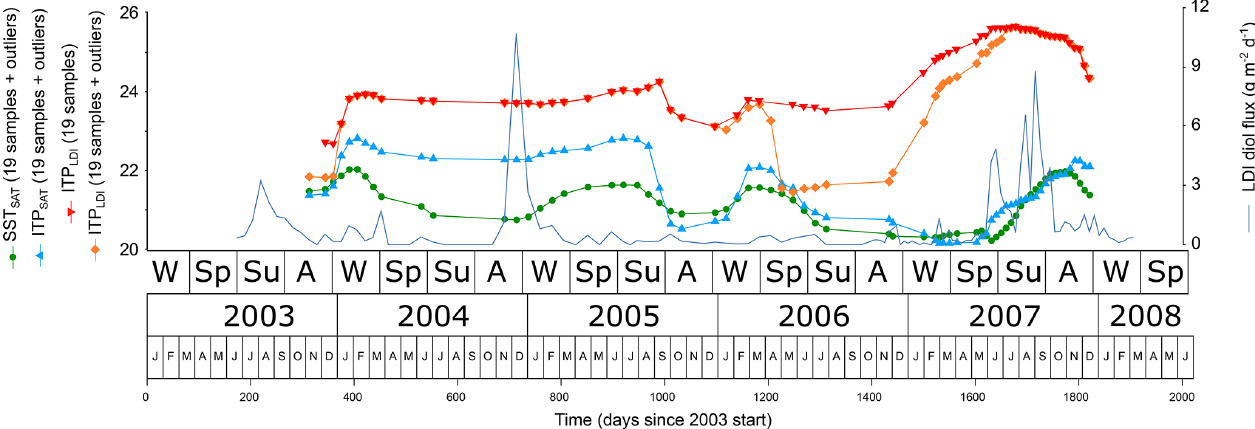
Figure 11. The 19-sample moving-average SST SAT (green spheres) and 19-sample moving-integrated production temperatures for SST SAT (IPT SAT , blue upward triangles) and for SST LDI (IPT LDI , orange diamonds), both based on the LDI diol fluxes and the respective SST records. Samples with LDI outliers (values < 17 ◦ C) are included except for the upper graph of IPT LDI (red downward pointing triangles). For reference, the LDI diol flux is included as